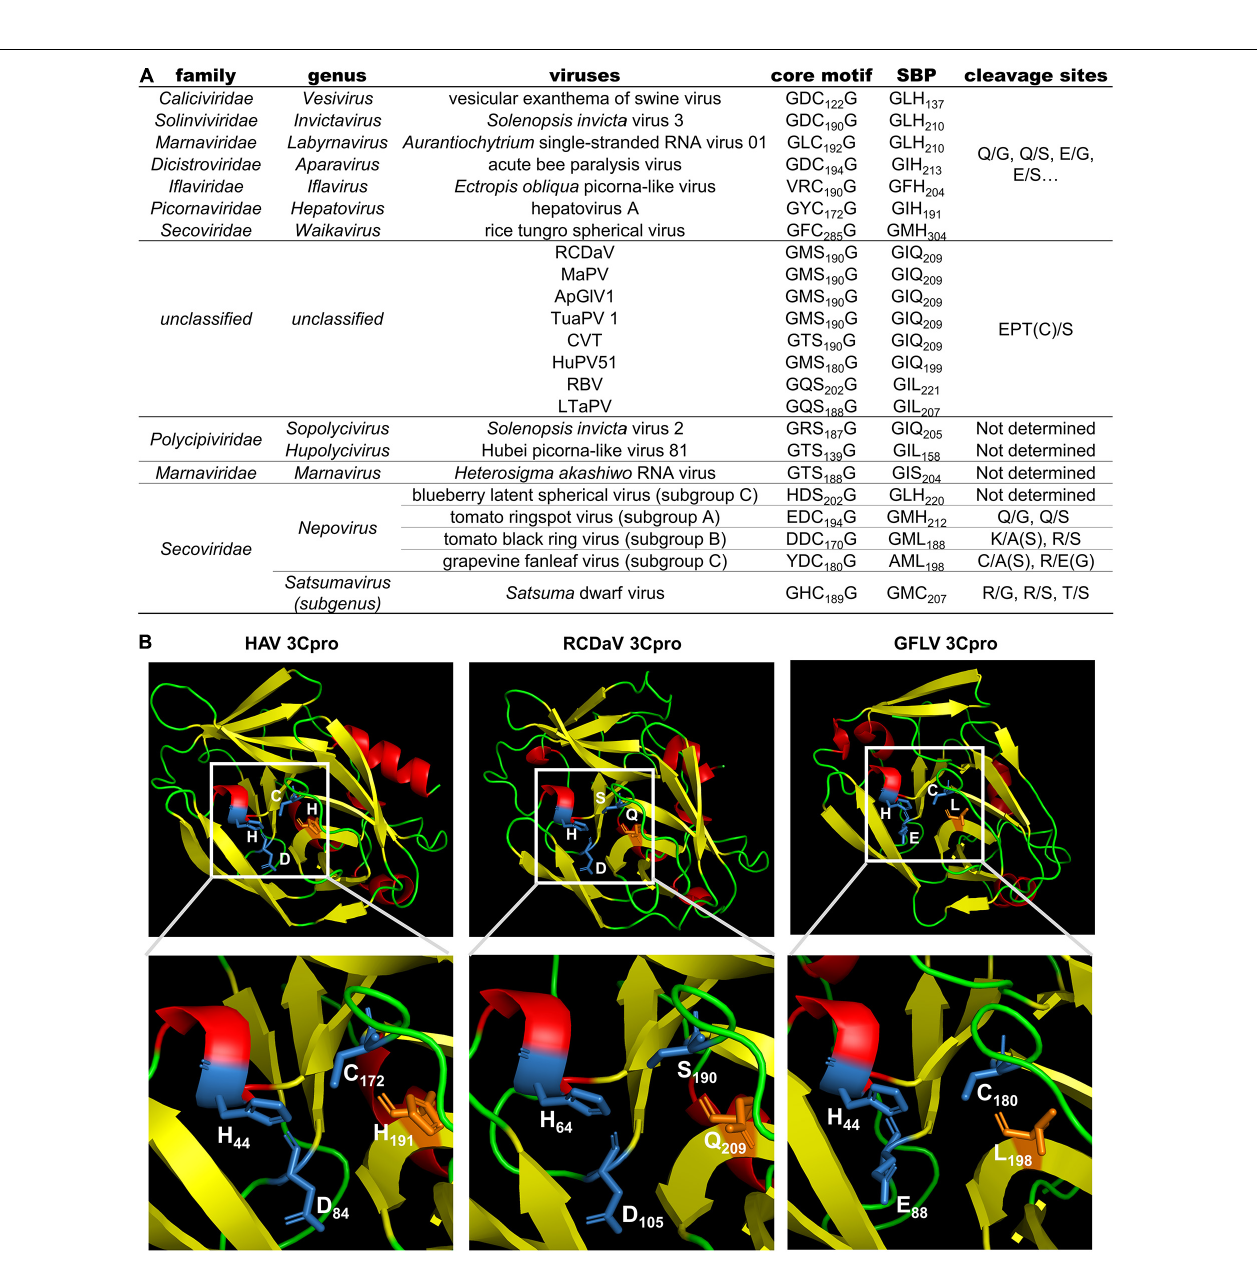
FIGURE 8 | Comparison analyses of the 3Cpro sequence and 3D structure from viruses in the order Picornavirales. (A) Comparison results of the core motif, partial substrate binding pocket (SBP) and cleavage sites of 3Cpros from viruses in the order Picornavirales. The cleavage sites of viruses from eight official families were obtained or predicted from previous studies (Allaire et al., 1994; Hemmer et al., 1995; Blom et al., 1996; Thole and Hull, 1998; Ye et al., 2012; Kristensen et al., 2018; Mann and Sanfaçon, 2019; Sanfaçon et al., 2020). (B) The 3D structure comparison of 3Cpros from HAV, RCDaV and GFLV. The 3D structure of HAV 3Cpro was downloaded from the RCSB PDB database (https://www.rcsb.org/, ID: 1QA7). The 3D structures of 3Cpros from RCDaV and GFLV were predicted using the HAV 3Cpro as the template through SWISS-MODEL homology-modeling server. The secondary structures are shown in different colors: red, helix; yellow, sheet; green, loop. The residues of catalytic triad are highlighted by blue and the key residues of S1 position of the SBP are highlighted in